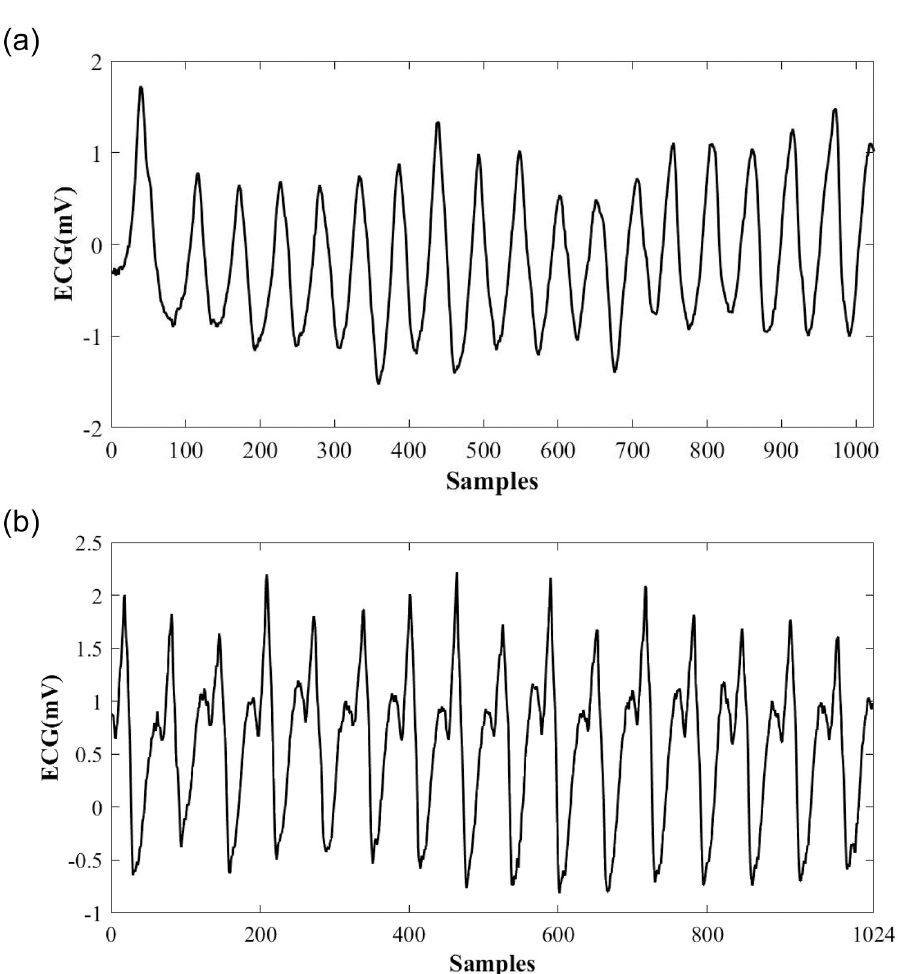
Fig 1. Shockable ECG signals. A: An example of a VFib ECG signal (top). B: An example of a VT ECG signal (bottom).